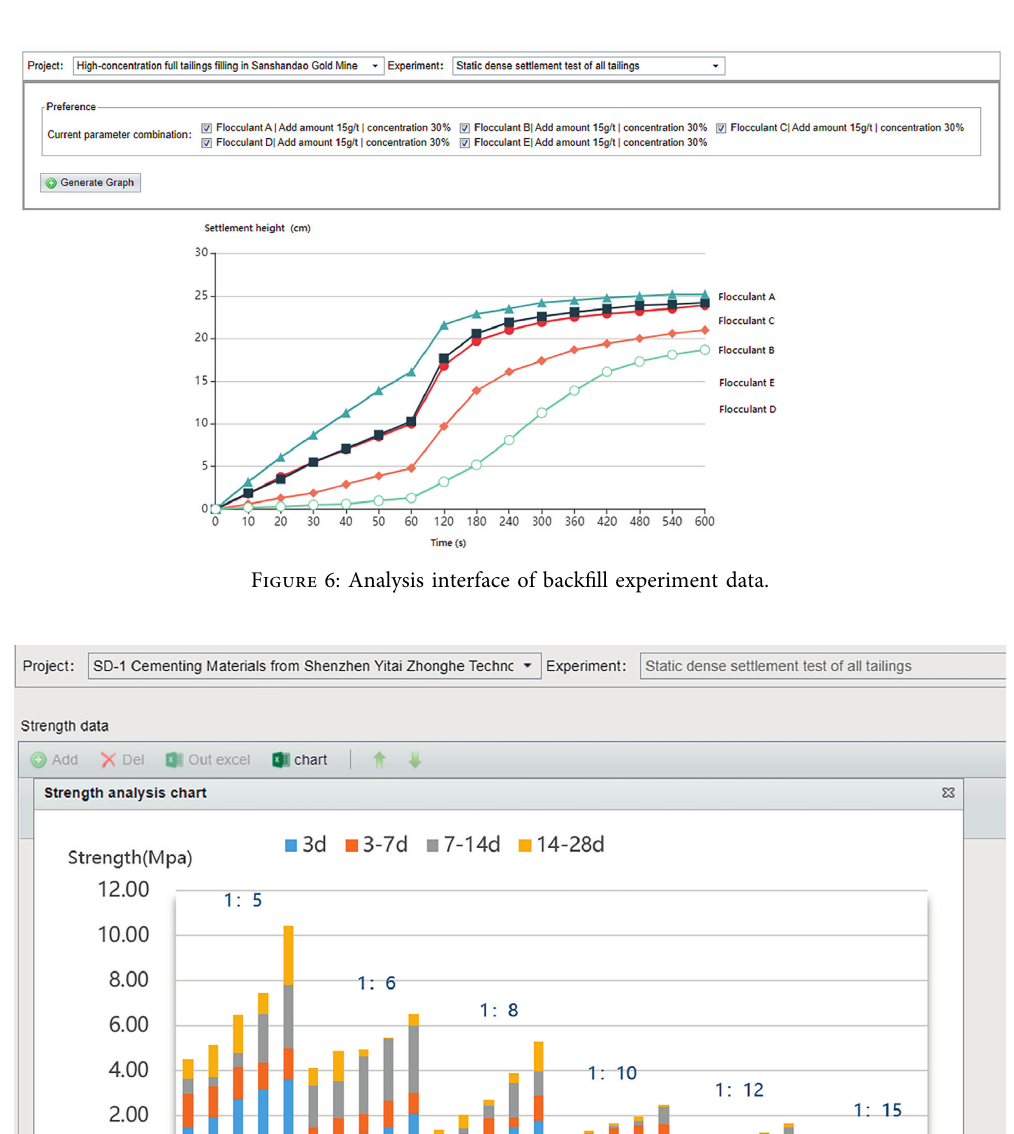
Figure 5: Input interface of backfill experiment data.